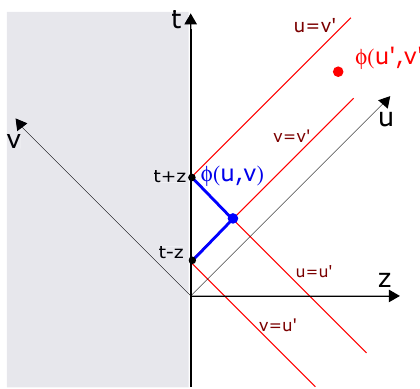
). Singularities in the propagator (cid:31) , v (cid:31)